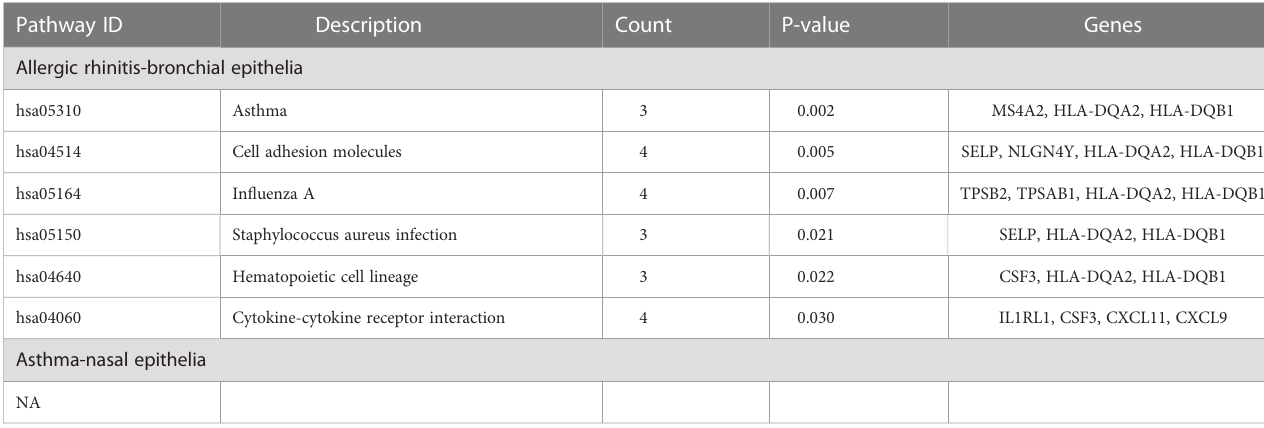
TABLE 5 KEGG pathways analysis results of DEGs. Pathway